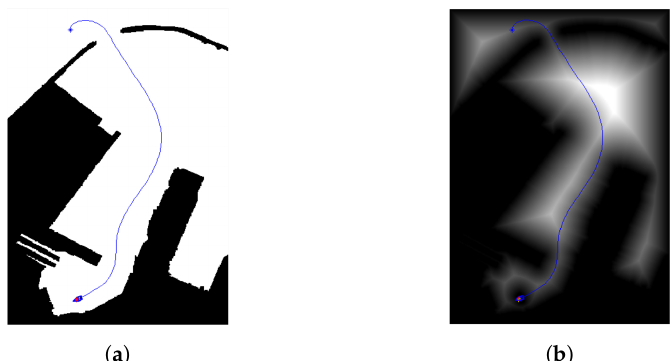
Figure 20. The simulation final result in static sea environment. ( a ) The binary map; ( b ) The potential map.